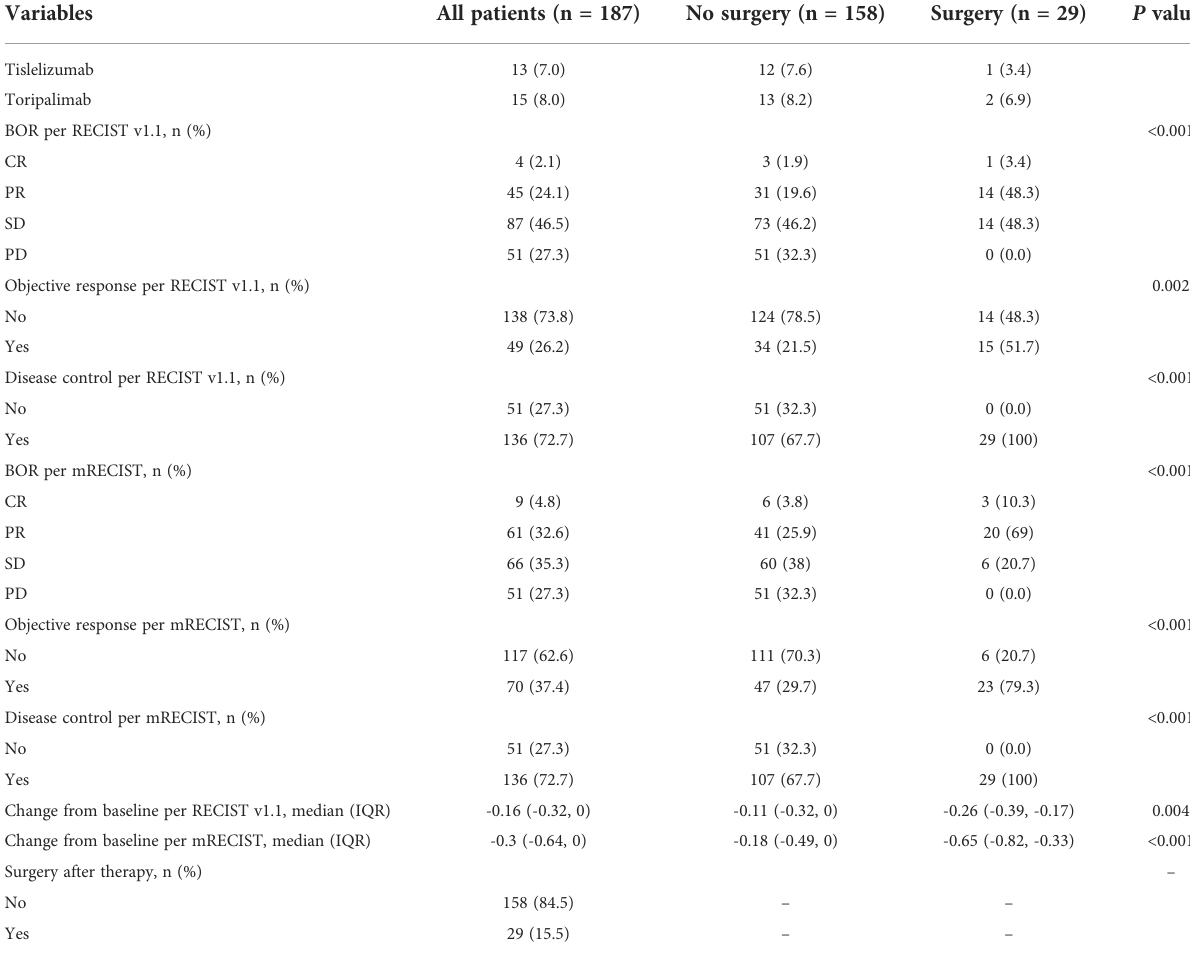
Criteria in Solid Tumors; SD, stable 0.001; Figure 1), which indicated that surgery following conversion therapy can provide a survival bene fi t.